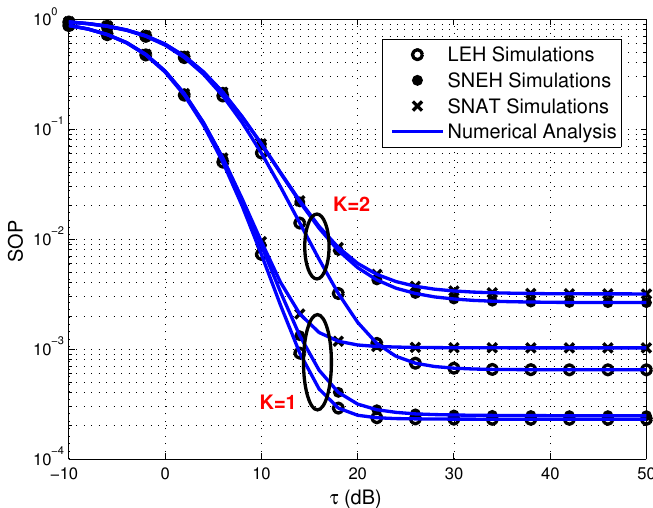
Figure 5. Secrecy outage probability versus τ for three EH modes under various K , where K = { 1,2 } .